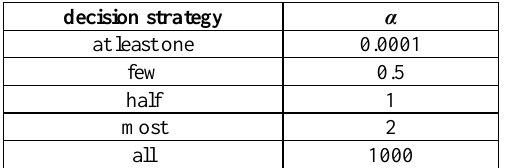
Table 1. Different decision strategies and their matching .